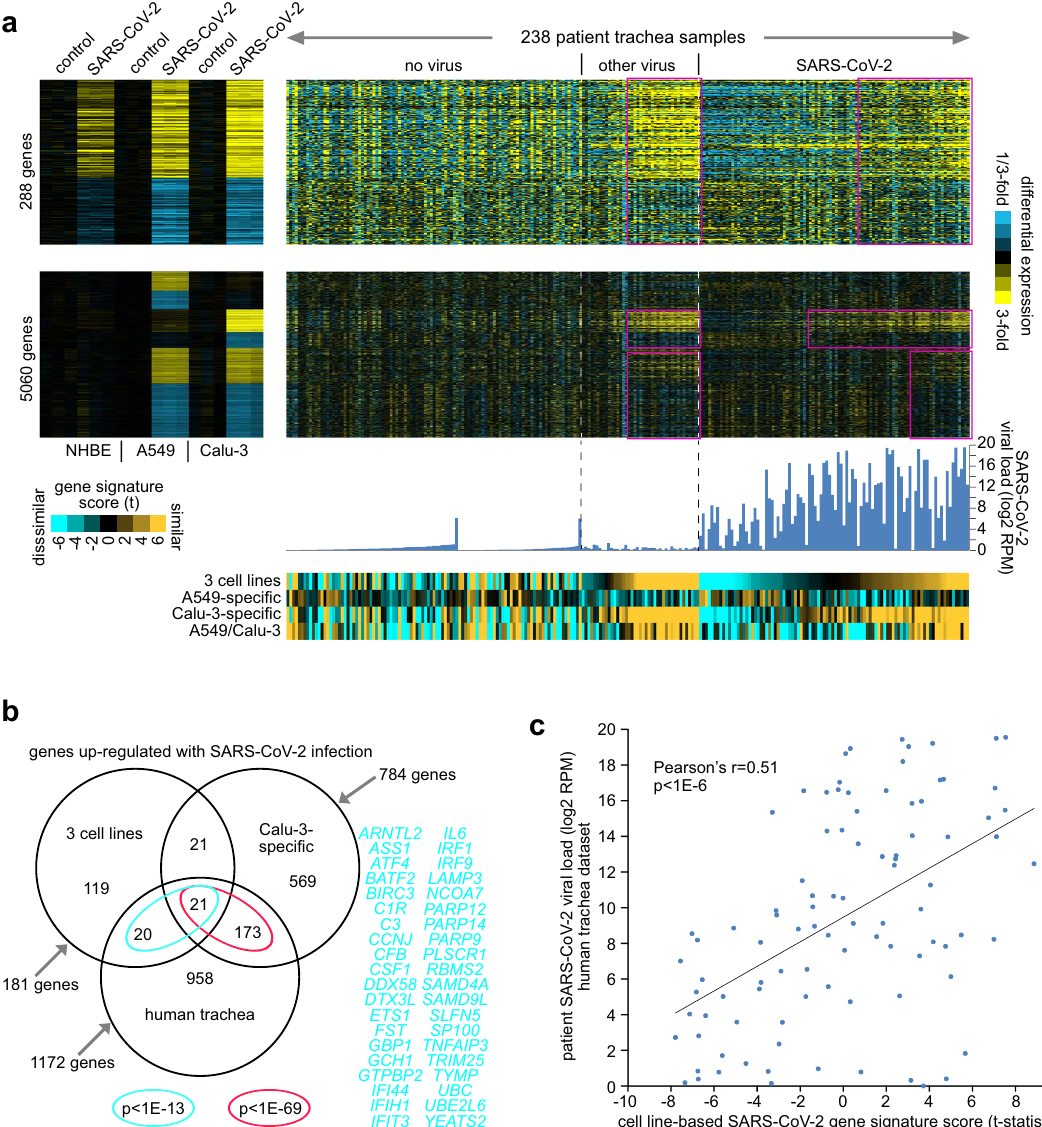
Figure 4. The SARS-CoV-2 in vitro transcriptional signatures are manifested in upper airway samples from COVID-19 patients. ( a ) An RNA-seq dataset of upper airway (trachea) samples in 238 patients with COVID-19, other viral, or non-viral acute respiratory illnesses was examined 8 . The patient expression profiles were probed according to the SARS-CoV-2 transcriptional signatures. Differential SARS-CoV-2-associated expression patterns common to all three cell lines (NHBE, A549, Calu-3) or found for just one or two cell lines (from Fig. 2b,c) are shown for both the in vitro SARS-CoV-2 infection dataset and the patient dataset. Gene order is the same across both datasets. SARS-CoV-2 viral loads (log2 reads per million) corresponding to the patients are also plotted. Heat map contrast (bright yellow/blue) is threefold change from either mock control for the in vitro dataset or from no virus group for the patient dataset. Selected patterns of manifestation of the in vitro SARS-CoV-2 signatures within the human dataset are highlighted. Under the differential expression heat maps, scores for each of the in vitro SARS-CoV-2 signatures across the patient profiles are represented (orange-cyan heatmap). ( b ) Venn diagram representing the gene set overlaps among the genes high with SARS-CoV-2 infection in vitro in all three cell lines (from Fig. 2b), the genes high specifically in Calu-3 lung cell line (from Fig. 2c), and the genes positively correlated with SARS-CoV-2 viral load across the 238 patient samples (p < 0.01, Pearson’s correlation using log2-transformed data). p values by one-sided Fisher’s exact test. Genes overlapping between three cell line gene set and patient gene set are listed. ( c ) Scatterplot of cell line-based SARS-CoV-2 gene signature score versus SARS-CoV-2 viral load, for the 94 COVID-19 patients in the human trachea dataset. See also Supplementary Data